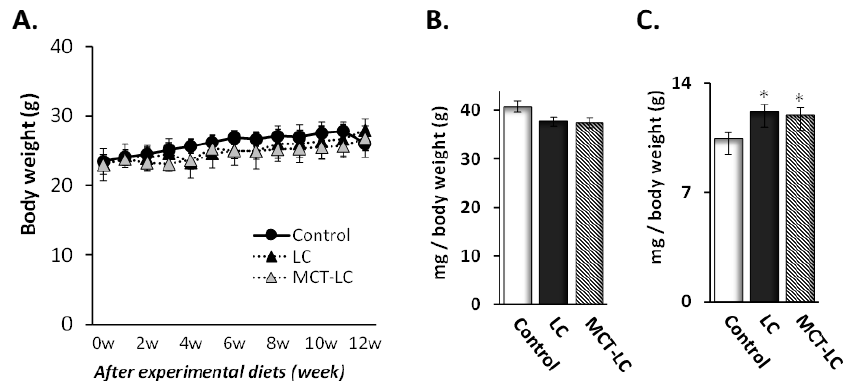
Figure 1. Body weights ( A ), liver weights (per gram of bodyweight) ( B ), and kidney weights (per gram of bodyweight) ( C ) of mice receiving experimental and control diets. Data shown are mean ± SEM. Control, control diet; LC, low-carbohydrate diet high in lard; MCT-LC, low-carbohydrate diet high in medium-chain triglyceride. * p < 0.05 vs. control by the Tukey’s HSD test.